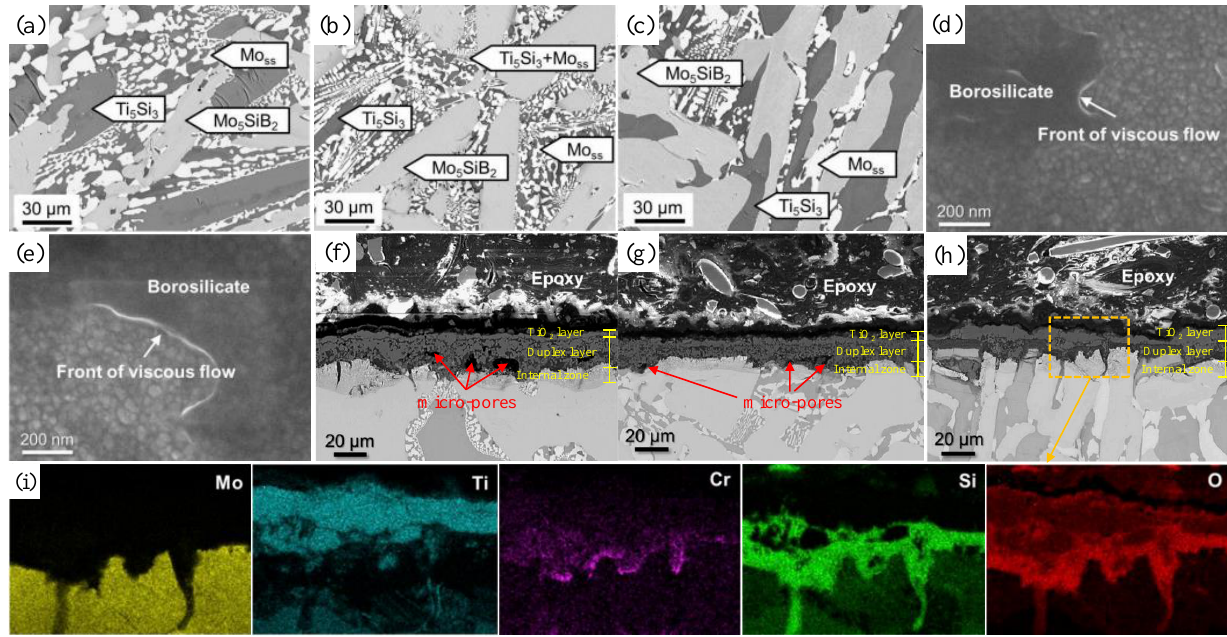
Figure 18. BSE images: ( a ) BASE, ( b ) AL and ( c ) CR; Surface SE images of different samples after oxidation 30 min at 700 °C: ( d ) AL and ( e ) CR; Cross-sectional BSE images of different samples after oxidation 24 h at 1100 °C: ( f ) BASE, ( g ) AL and ( h ) CR; ( i ) Elemental mappings of the micro-zone. Reproduced with permission [80]. Copyright 2020 Elsevier.